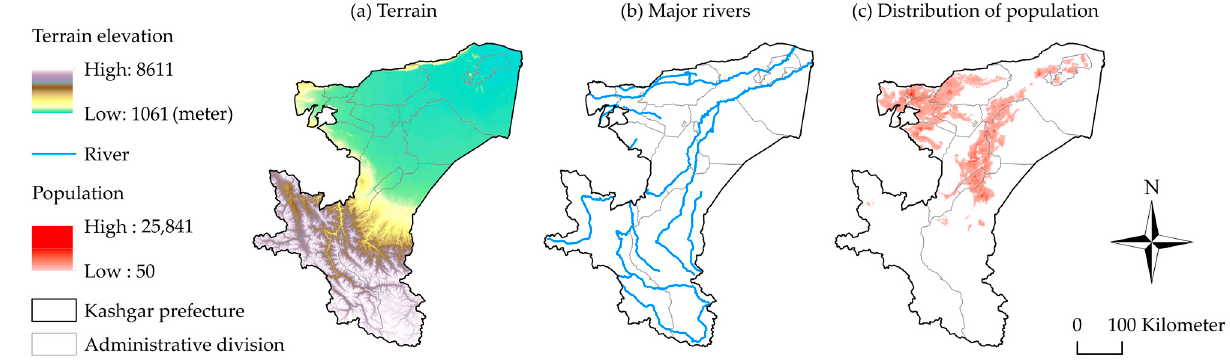
Figure 2. Schematic diagram of nature and population of the Kashgar region.